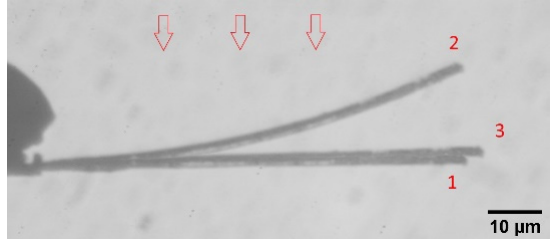
Figure 2. Combined image of the crystal at three different moments of transformation at λ = 465 nm: (1)—initial state of the crystal, (2)—position of maximum bend (irradiation for 3 min), (3)—final shape of the crystal (after 36 min of irradiation). The arrows indicate the direction of light.